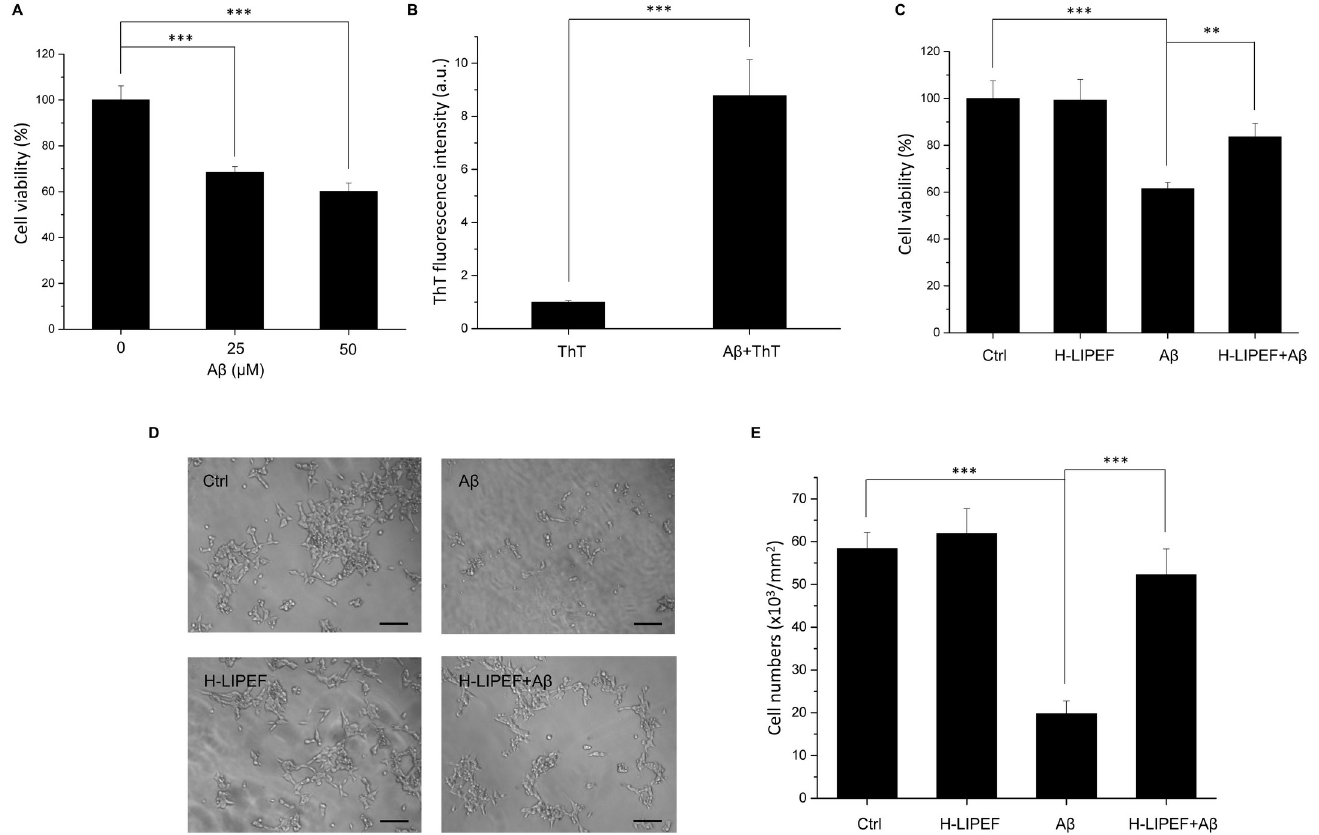
Fig 5. Effect of H-LIPEF on A β -induced cytotoxicity in SH-SY5Y cells. (A) The cell viability of SH-SY5Y cells treated with 25 or 50 μ M A β for 4 days. (B) The A β aggregation state was assessed by the ThT fluorescence. (C) The SH-SY5Y cells were pretreated with H-LIPEF for 4 h and then exposed to 50 μ M A β in the continuous administration of H-LIPEF for another 4 days, and the cell viability was measured by MTT assay. (D) Representative light microscopy images of SH-SY5Y cells after A β and/or H-LIPEF treatment. The integrity of the cells was destructed by A β , and the H-LIPEF treatment caused the protective effect and retained the cell morphology. Scale bar = 100 μ m. (E) Quantification of the cell numbers in the light microscopy images by ImageJ software. Data represent the mean ± standard deviation (n = 3). Cell viability of SH-SY5Y cells treated with different concentration of A β and the ThT fluorescence experiment were statistically analyzed using one-way ANOVA with Tukey’s post hoc test ( ��� P < 0.001). Comparisons of the effect of A β and H-LIPEF on the cell viability and the cell numbers were analyzed using two-way ANOVA with Tukey’s post hoc test ( ��� P < 0.001 and �� P <